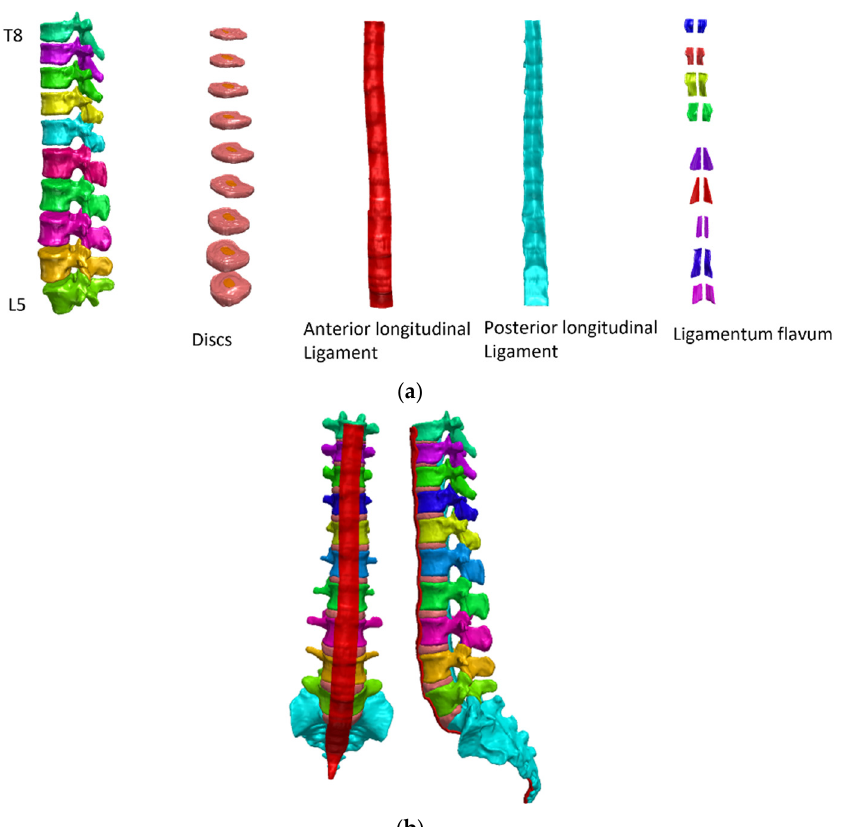
Figure 2. ( a ) T8 to the sacrum, distinguishing each vertebral body, intervertebral disc, anterior longitudinal ligament, posterior longitudinal ligament, and ligamentum flavum. ( b ) A spine model was created.